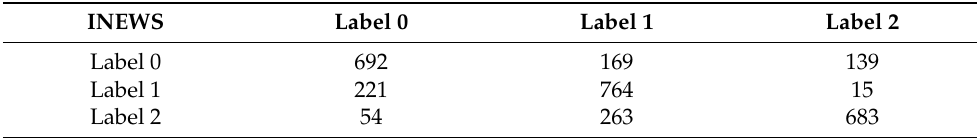
Table A3. Model performance. Confusion metric on INEWS.